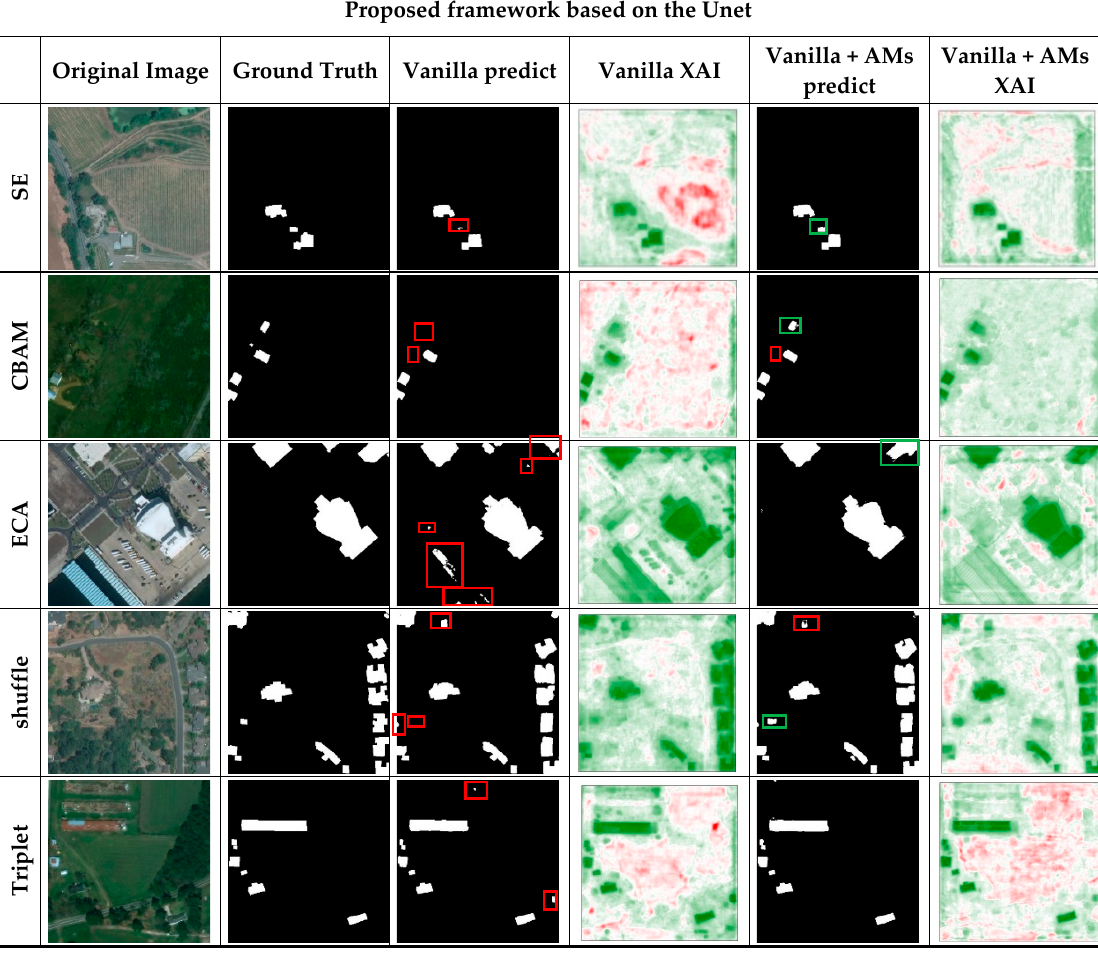
Figure 7. Visualization of predicted label for vanilla UNet and attention-based UNet and LayerDeepLIFT (Red box: missed building and wrongly labeld erDeepLIFT (red box: missed building and wrongly labeled building, green box: true building). In building, Green box: true building). In XAI outputs, related objects should be XAI outputs, related objects should be green and bolder than other objects. green and bolder than other objects. Table 3. Complexity comparison in terms of number of blocks, network parameters, inference time, and FLOPs. Comparing these terms indicates how much complexity AMs add to vanilla